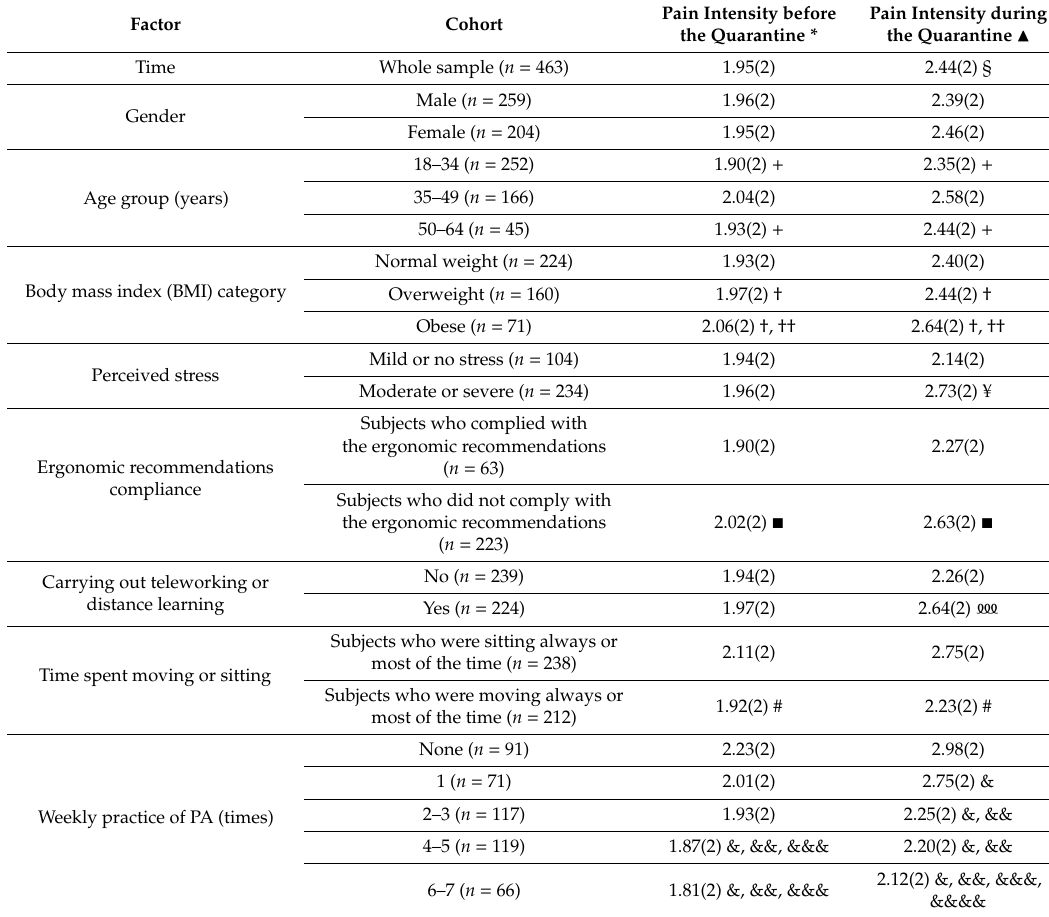
Table 2. Pain intensity due to di ff erent factors, periods, and